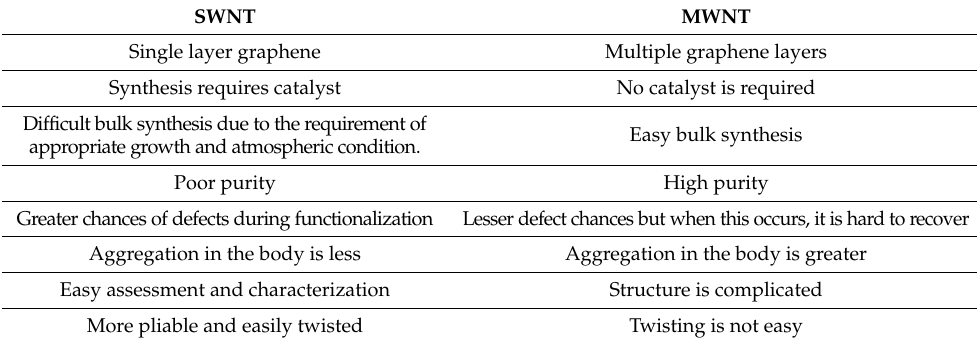
Table 1. Comparison between SWCNTs and MWCNTs. Adopted from [7]. SWNT MWNT Single layer graphene Multiple graphene